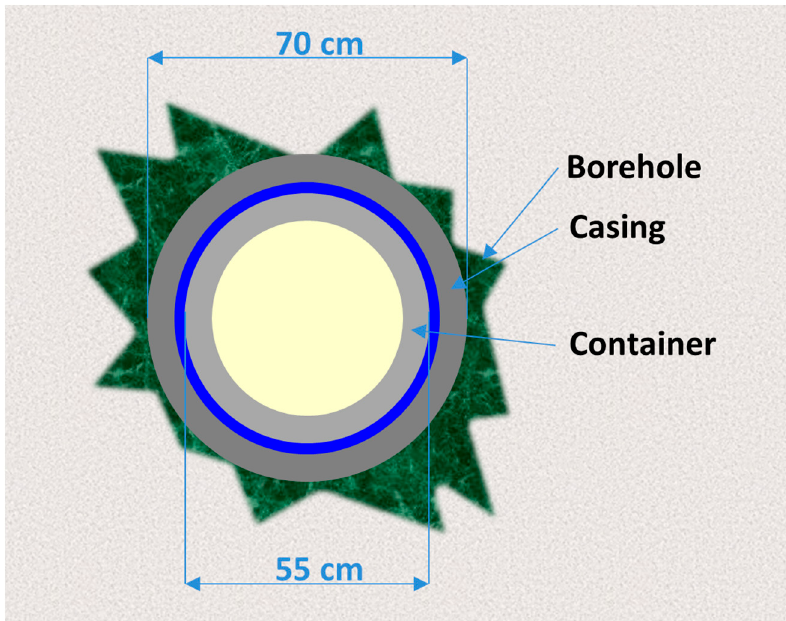
Table 1. Disposal depth, DBC-R per borehole and number of boreholes.